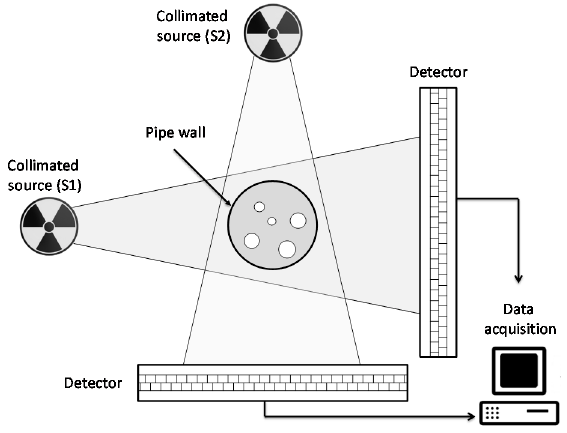
Figure 4. Principle of hard-field tomography.